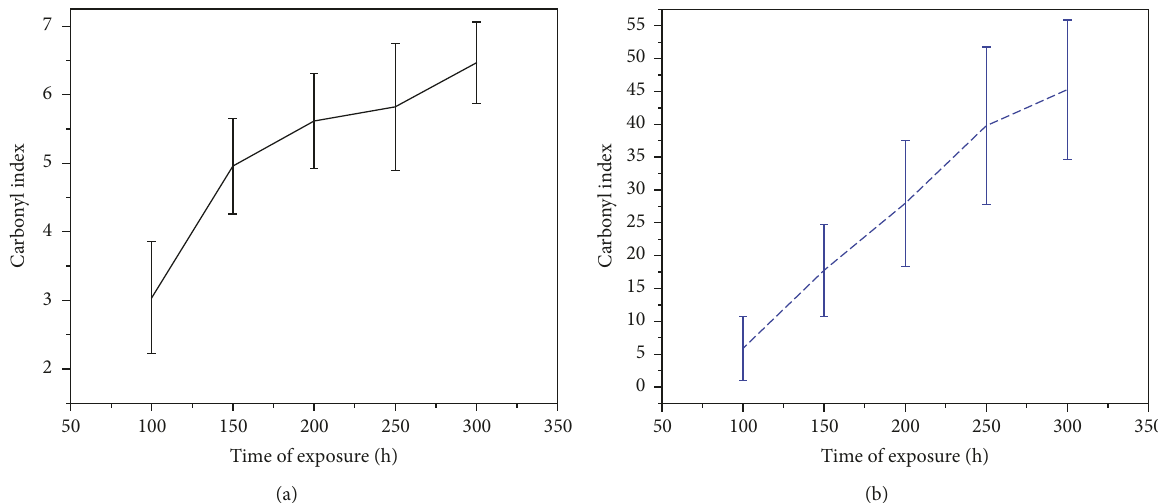
Figure 5: Variation of the oxo-degradable LDPE carbonyl index with time of exposure in a Xenon arc chamber calculated with (a) the total area and (b) the corrected area under the carbonyl band.